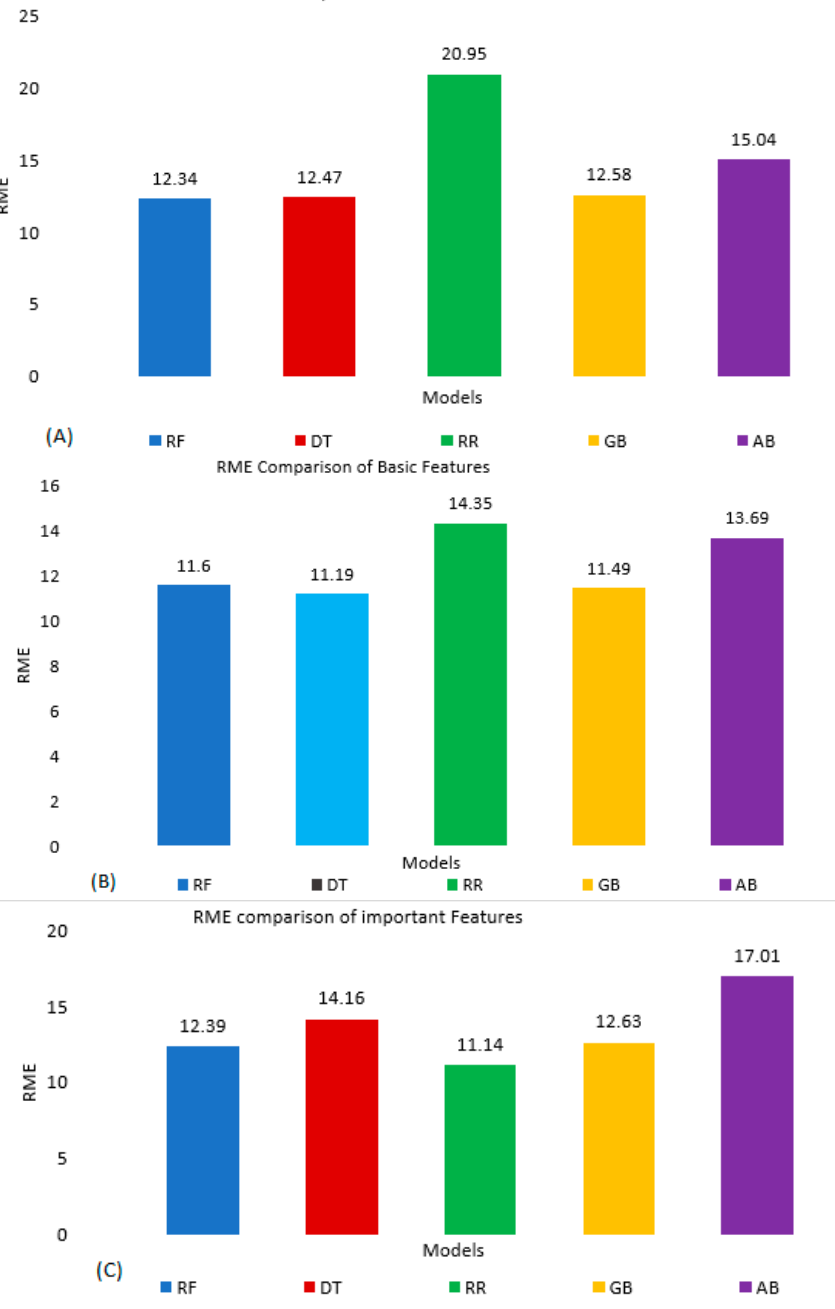
Figure 14. RME Comparisons of ( A ) all, ( B ) basic, and ( C ) important sparse matrix